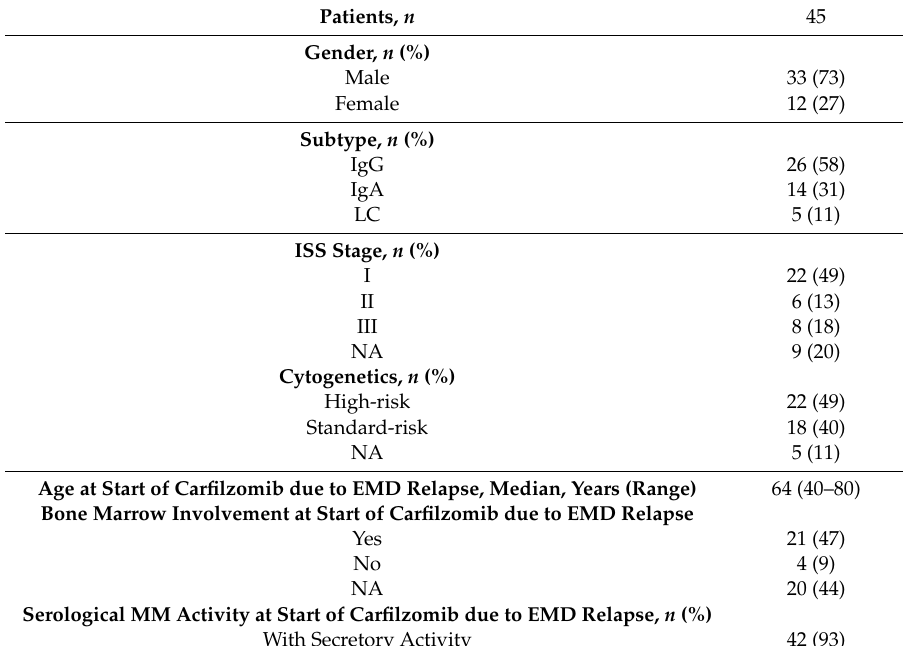
Table 1. Patients’